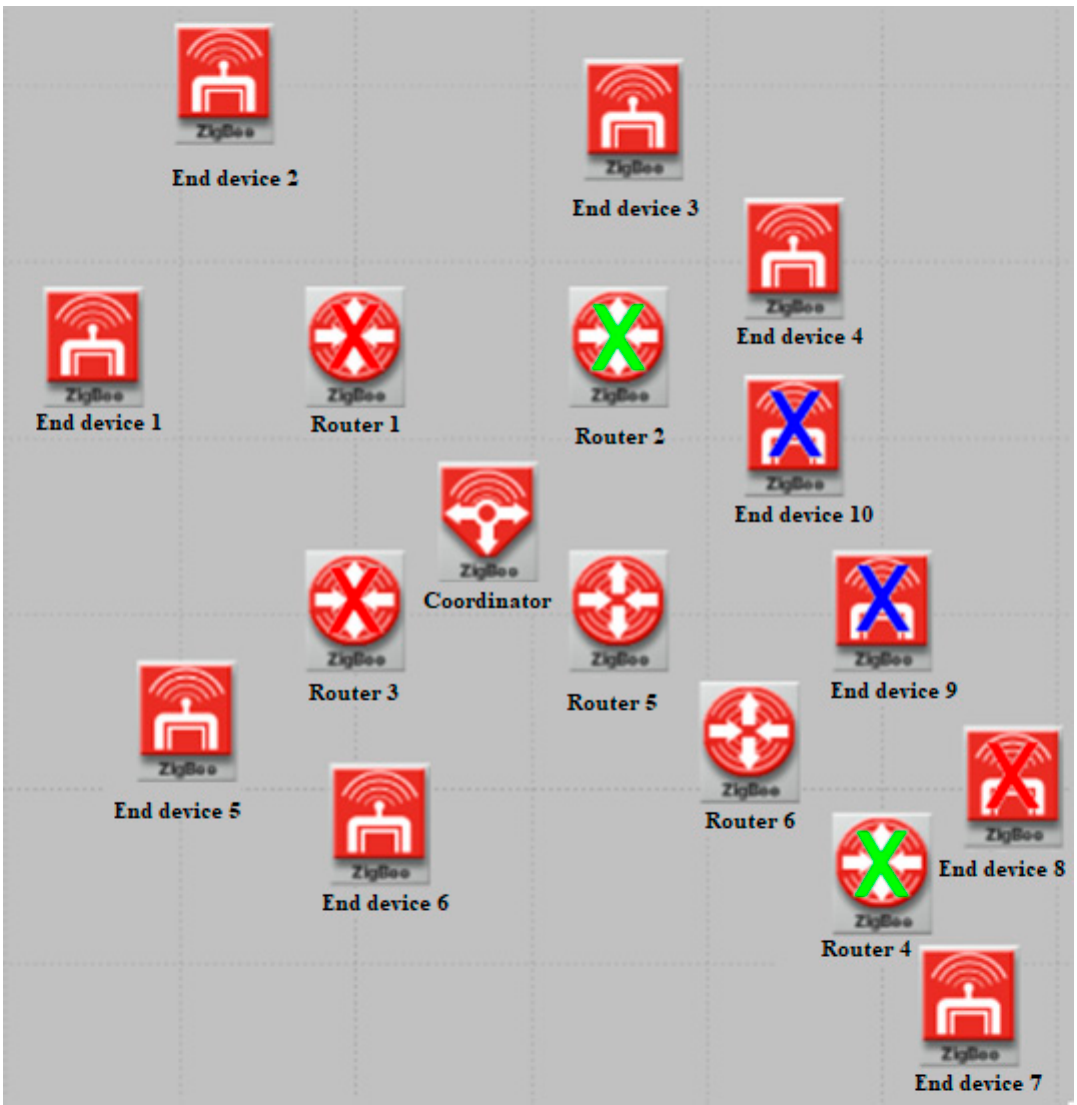
Figure 4. Network topology (green cross—nodes damaged in scenario II, blue cross—nodes damaged in scenario III, red cross—nodes damaged in scenario IV).